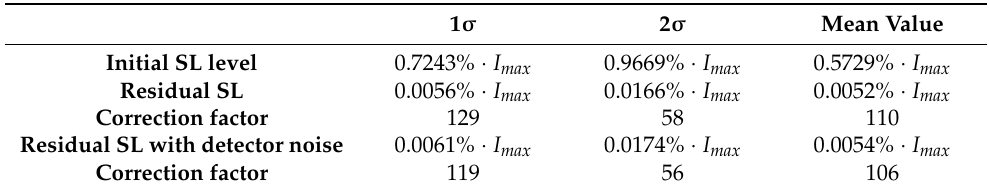
Table 1. SL performance of 3MI before and after correction with maps interpolated with the scaling method, considering or not the detector noise.